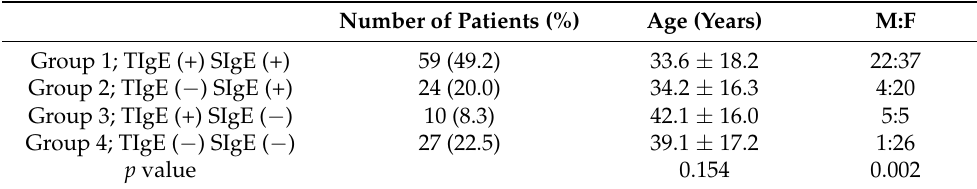
Table 2. Comparison of the test results between subgroups according to the detection of TIgE and SIgE.